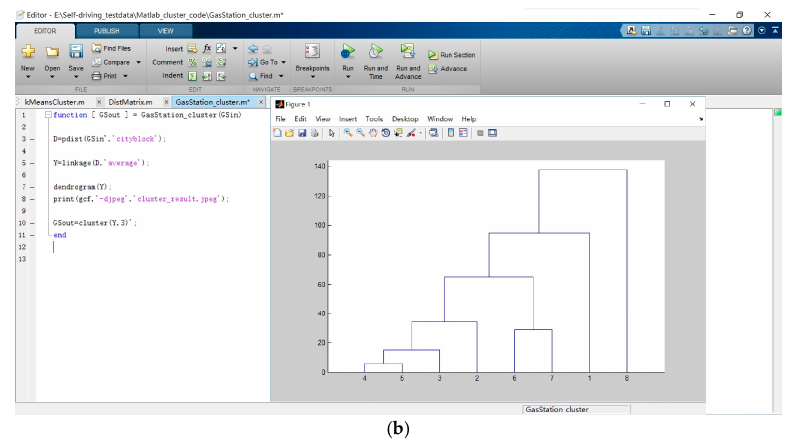
Figure 5. System development of scenario simulation based on ArcEngine and Matlab. ( a ) Interface of scenario simulation; ( b ) cluster analysis of gas stations based on Matlab.